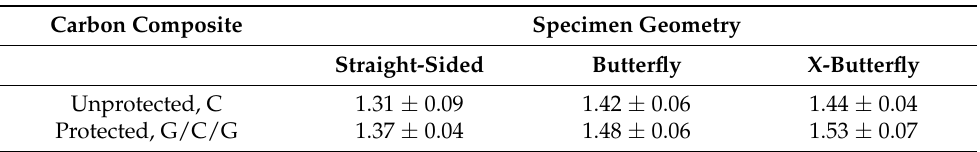
Table 3. Strain to failure (%) of unprotected (C) and protected (G/C/G) carbon composites with three specimen geometries.